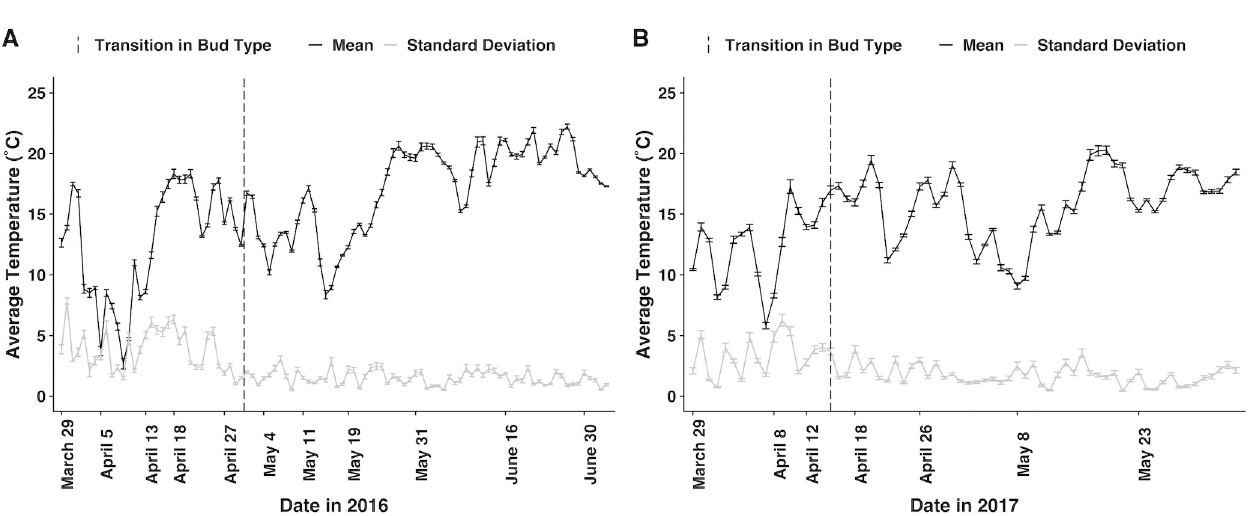
Fig 4. Seasonal temperature data including averaged mean and standard deviation measured in A) 2016 and B) 2017. For each of the 10 plots, temperature (˚C) was measured at 15-minute (2016) and 1-hour intervals (2017). For data visualization, temperature data were grouped by measurement date and averaged to portray single, weekly observations encompassing the entire population. Error bars reflect the standard error, and dashed vertical lines highlight bud type transition, the time at which chasmogamous budding ceased and the first cleistogamous buds were observed.